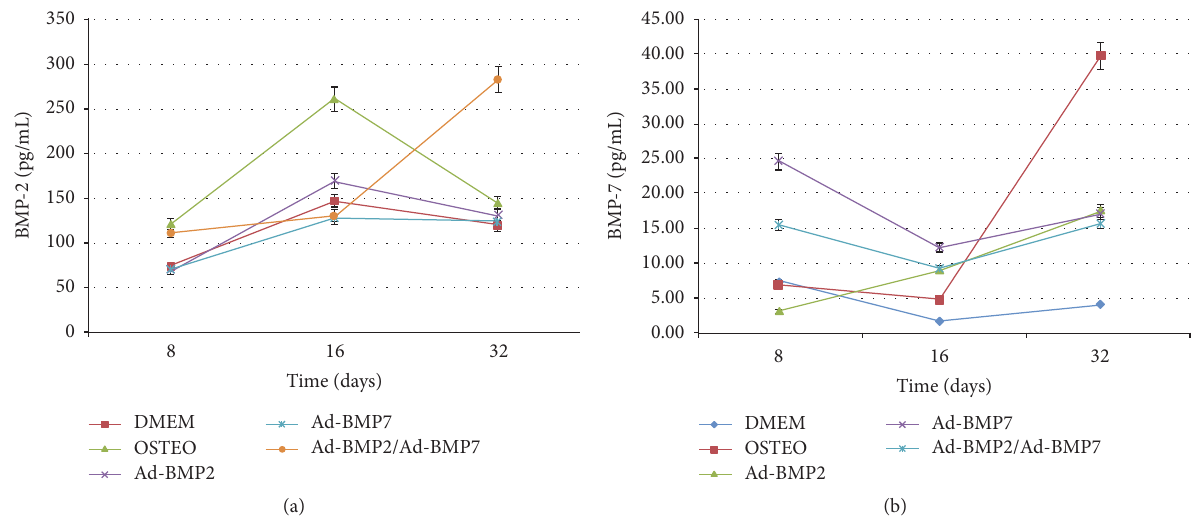
Figure 3: ELISA. (a) Analysis of the protein BMP2 and (b) BMP7 by ELISA of MSCs transduced with the vectors AdBMP2, AdBMP7, the combination AdBMP2/AdBMP7, and the positive (OSTEO) and negative (DMEM) controls on days 8, 16, and 32 after induction.